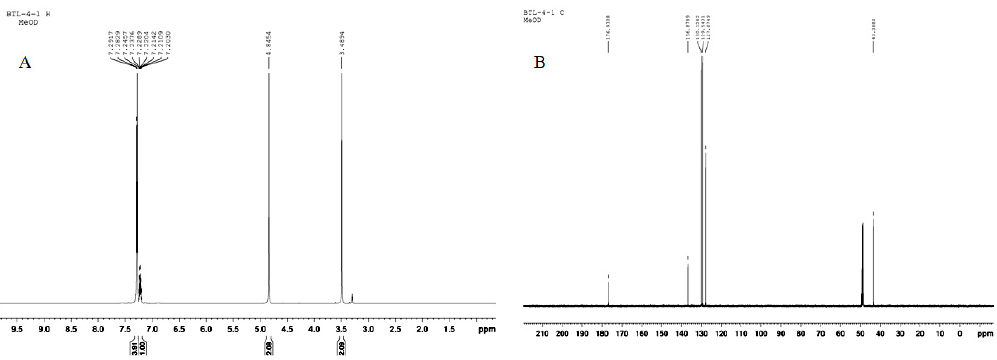
Figure 7. The 1 H-NMR ( A ) and 13 C-NMR ( B ) spectrums of PA (in CD 3 OD). The data of NMR are as follows: 1 H-NMR (CD 3 OD, 500 MHz) δ :7.29 (5H, m, H-2,3,4,5,6), 3.50 (2H, s, H-7); 13 C-NMR (CD 3 OD, 125 MHz) δ :136.9 (C-1), 130.1 (C-2,6), 129.6 (C-3,5), 127.9 (C-4), 43.4 (C-7), 177.0 (C-8).